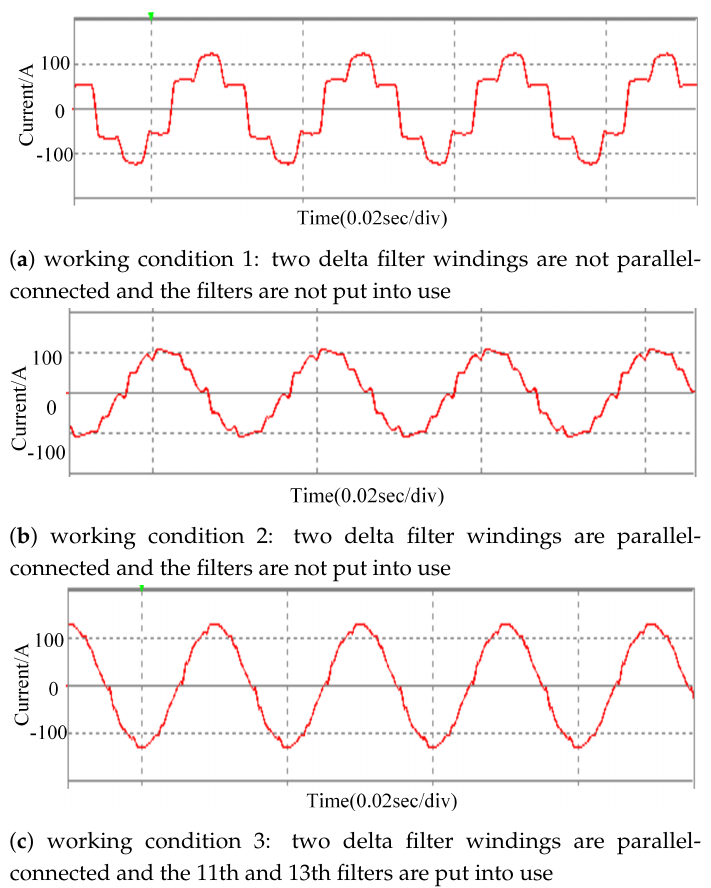
Figure 13. Measured waveform of winding current at the grid-side of the inductive filter converter transformer under three working conditions.